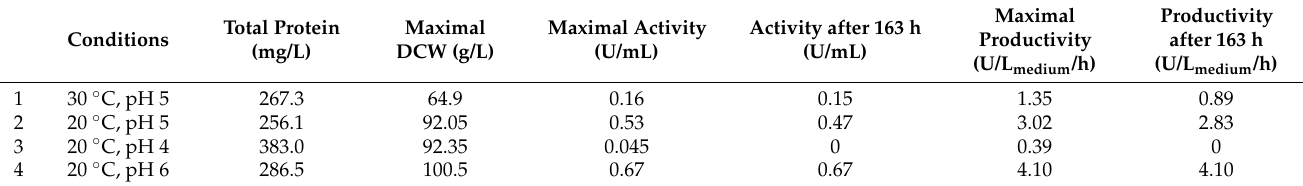
Table 2. Summary of Pichia pastoris fermentations optimizing myrosinase